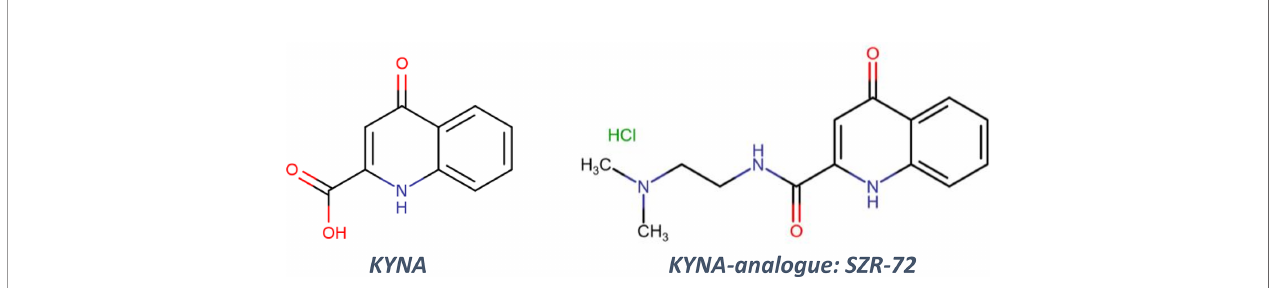
FIGURE 1 | The structure of kynurenic acid (KYNA) and its analogue SZR-72 (2-(2- N,N -dimethylaminoethylamine-1-carbonyl)-1 H -quinolin-4-one